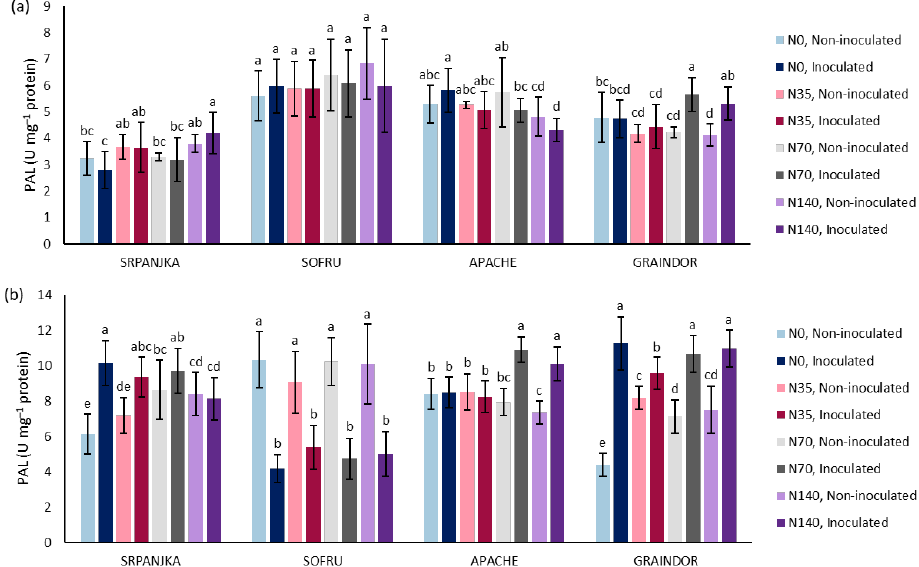
Figure 3. Phenylalanine ammonia-lyase (PAL) activity in spikes of four wheat varieties under different Fusarium (non-inoculated and inoculated) and nitrogen treatments (0, 35, 70, and 140 kg N ha − 1 ) in 2018/2019 ( a ) and 2019/2020 ( b ). Values are means of eight replicates ± standard deviation (SD). Different letters above the bars indicate significant differences according to Fisher’s LSD test ( p ≤ 0.05) among treatments in each variety separately.